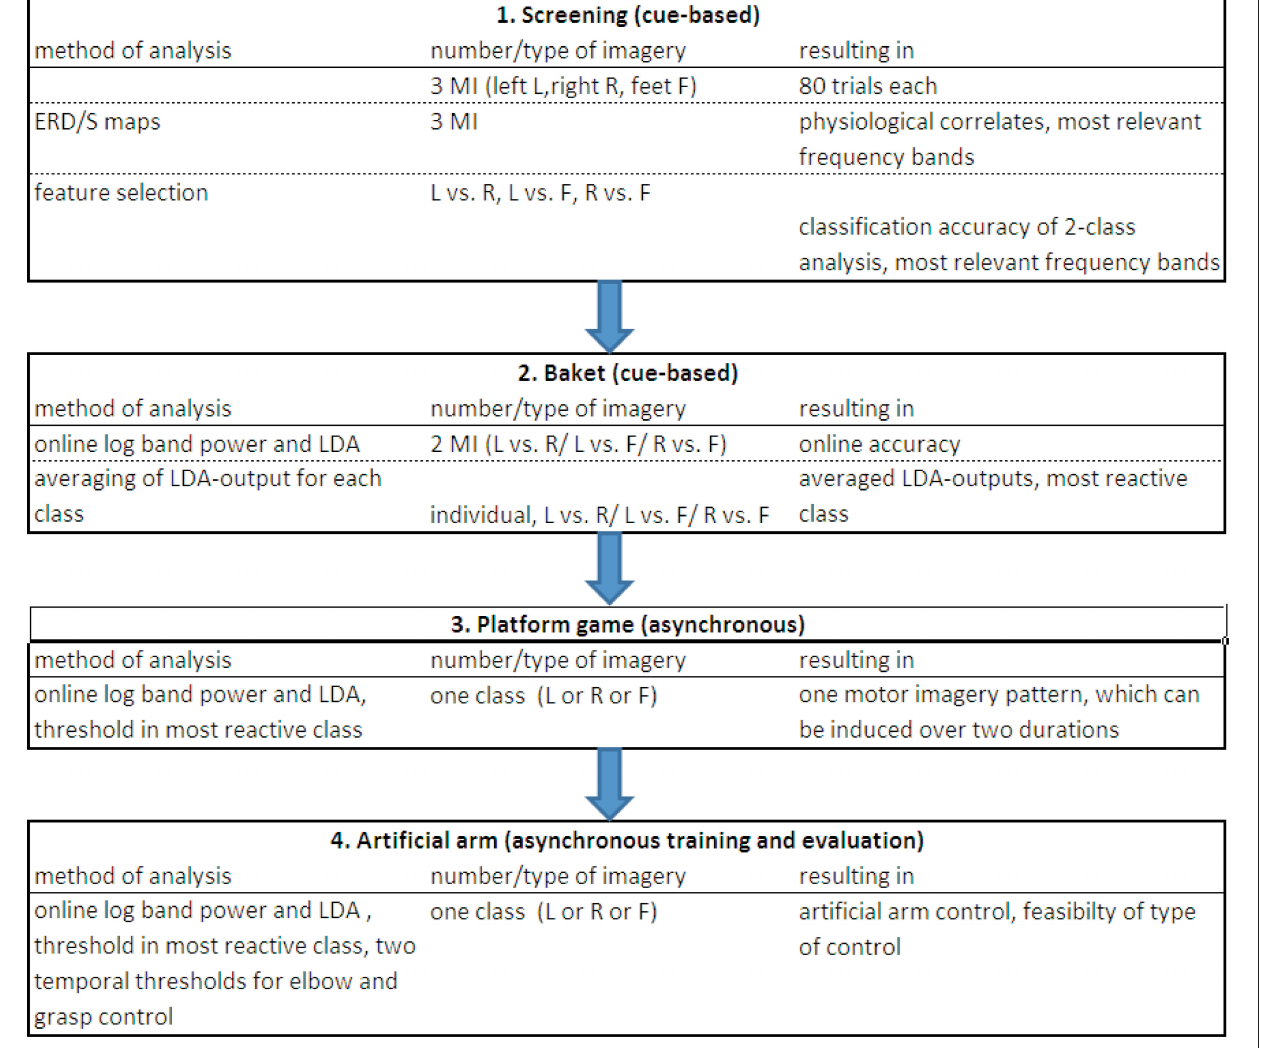
Figure 1 | Procedure for naïve BCi users to learn to control an artificial arm with only one out of three motor imagery (Mi) patterns (left, L; right, r, feet, F). Screening is performed with three types of MI, after feature extraction